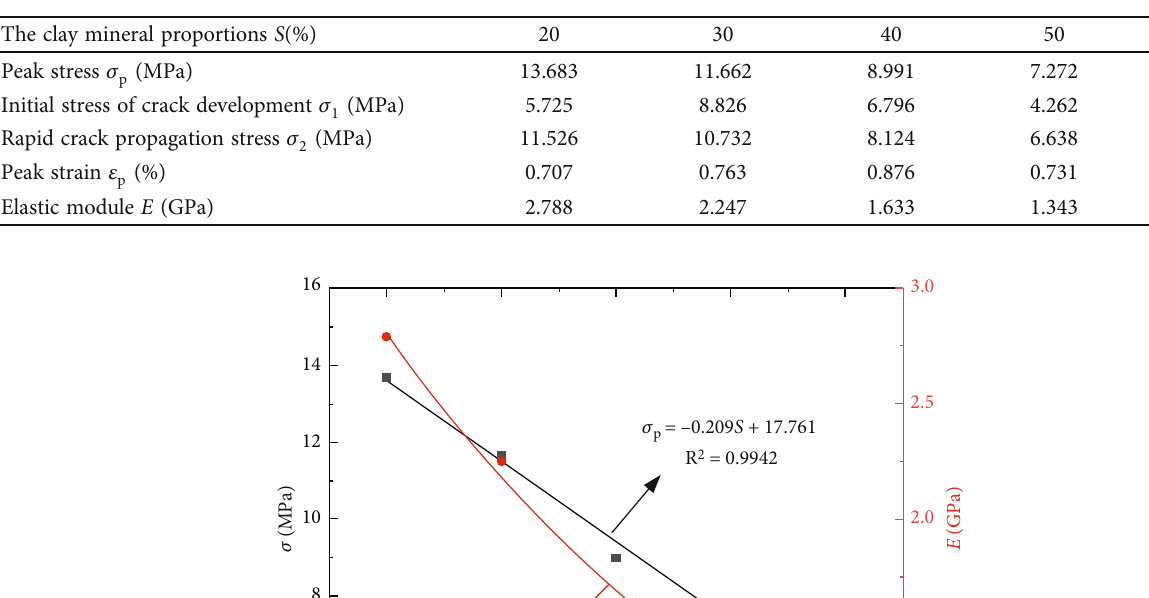
Table 3: Mechanical characteristic parameters of weakly cemented rock samples.